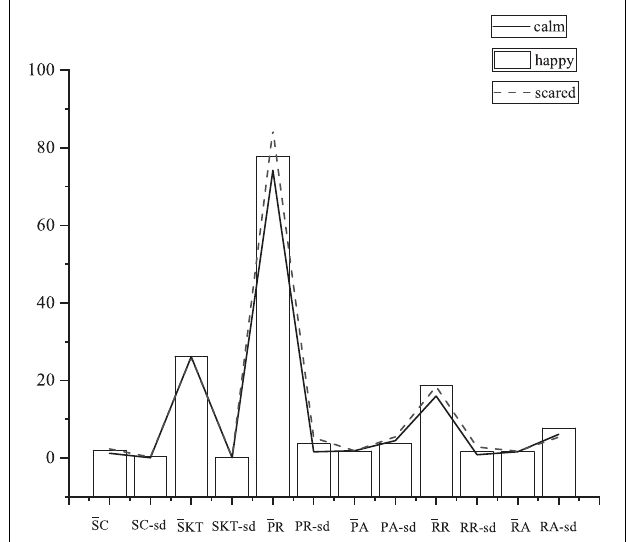
FIGURE 8 | Physiological signal characteristic parameters of a